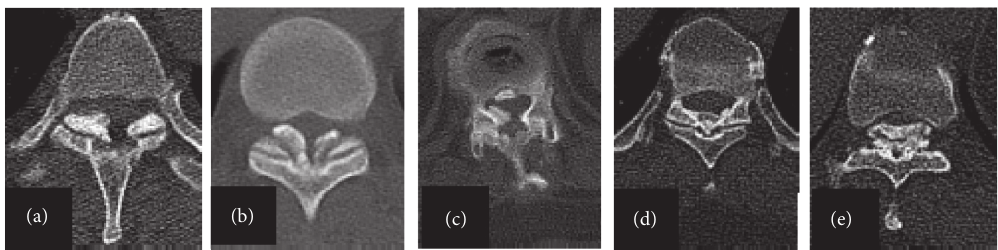
Figure 1: Sato’s classification of TOLF. A-E Sato’s classification: (a) lateral type, (b) extended type, (c) enlarged type, (d) fused type, and (e) tuberous type.